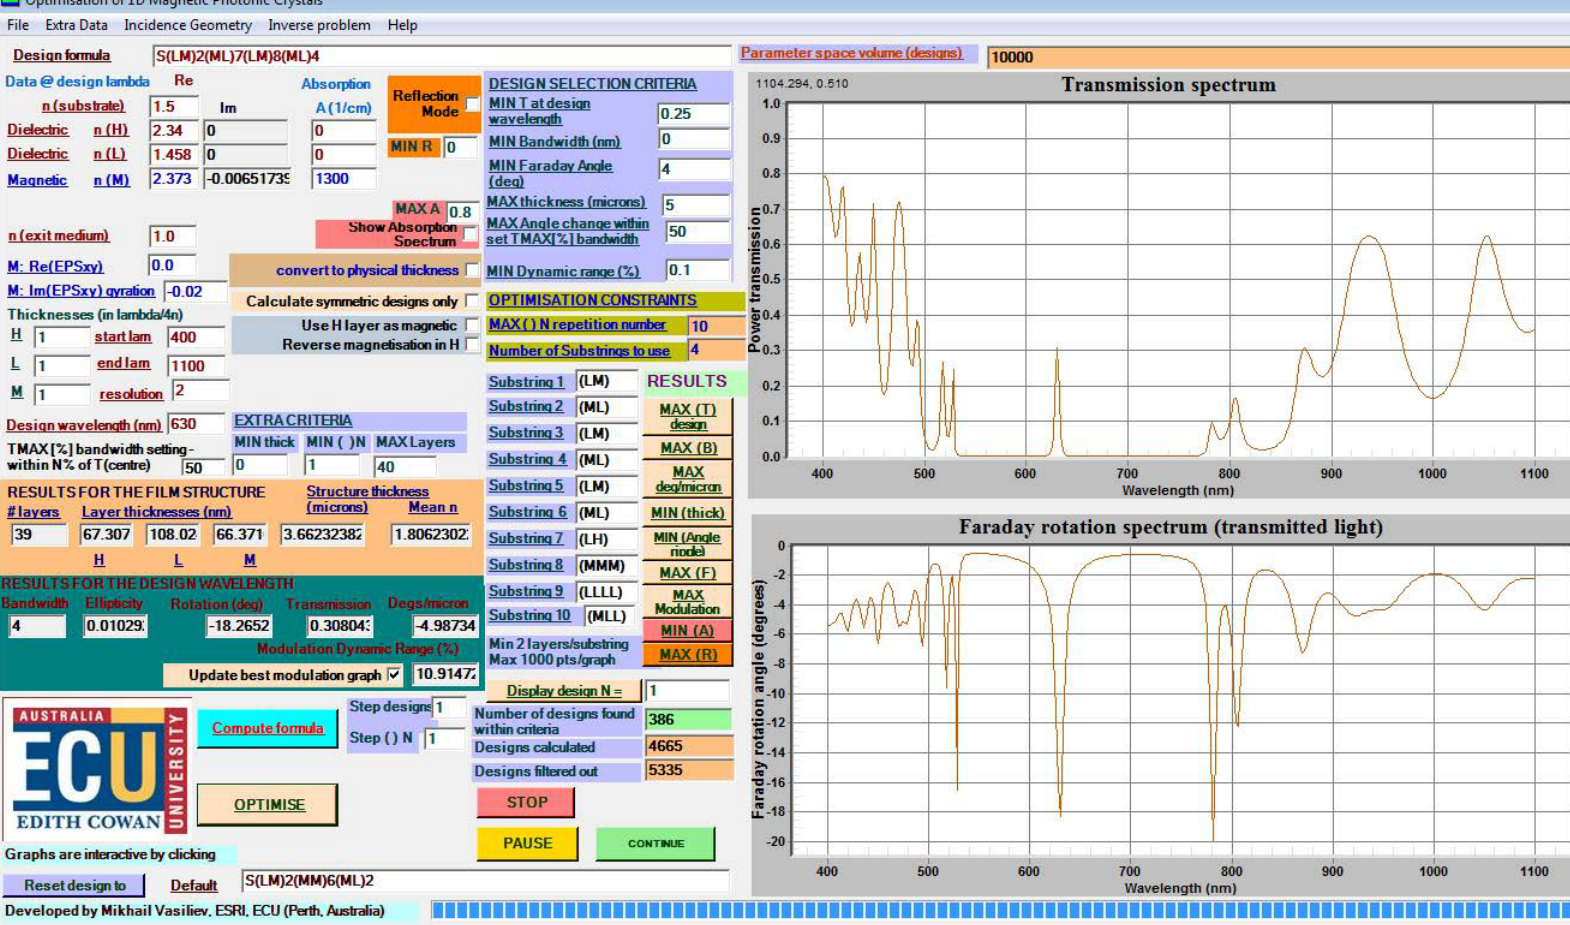
Figure 1. Front-panel controls of MPC Optimization software and a sample optimized MPC design obtained by clicking the “optimize” button without changing the default-entered data. The result is a MPC structure which is designed to operate at 630 nm, reliant on a magnetic garnet material of specific Faraday rotation near 2 ◦ / µ m at that wavelength, however, the structure enhances the Faraday rotation to 4.98 ◦ / µ m within the spectral transmission